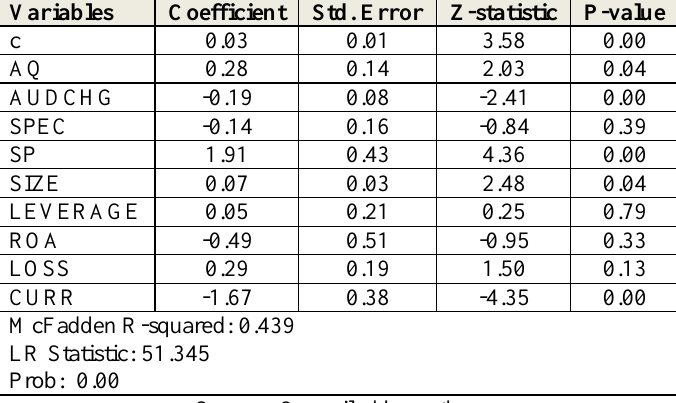
Table 3 . The results of the testing first hypothesis